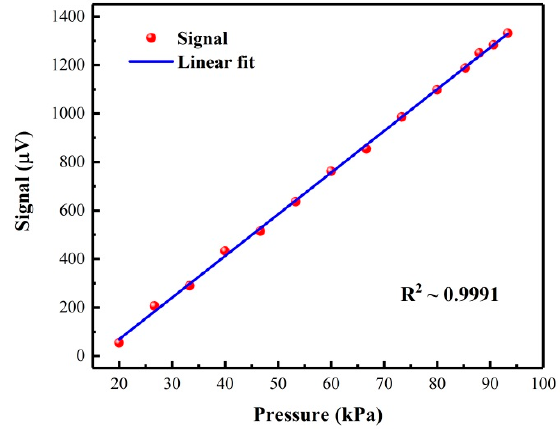
Figure 6. NO 2 photoacoustic signal as a function of the pressure. Figure 6 . NO Figure 6 . NO 2 photoacoustic signal as a function of the pressure. 2 photoacoustic signal as a function of the pressure.